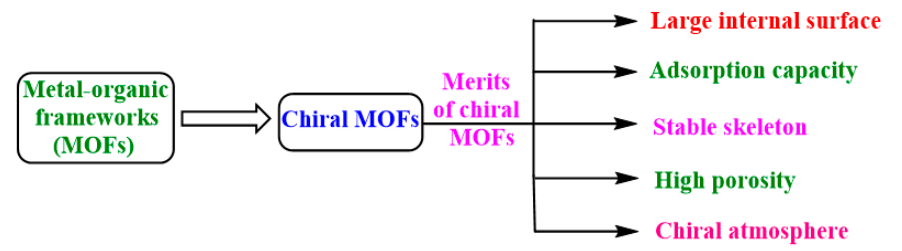
Figure 1. Typical structural requirement for chiral MOFs for their applications.